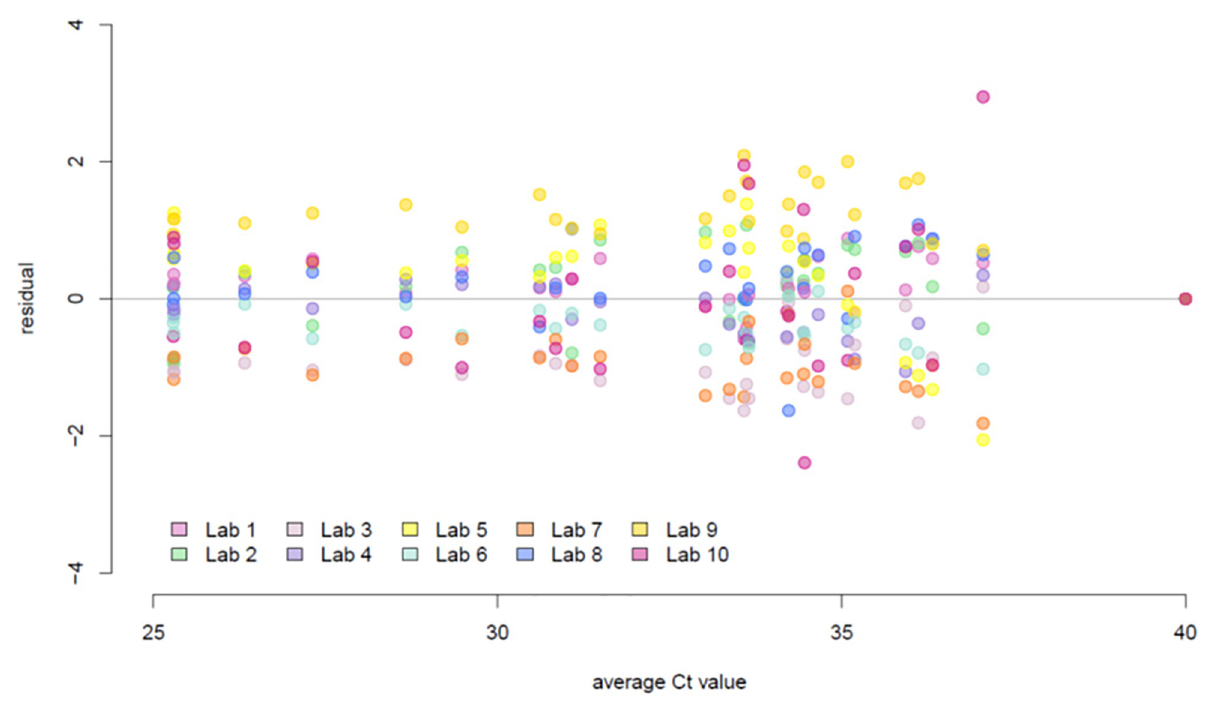
Fig 4. Distribution of C t residuals relative to sample-specific average C t values. Residuals were consistent between laboratories regardless of viral load. Residuals were plotted against sample-specific average C t values. Each colored dot represents a different participating laboratory per legend.